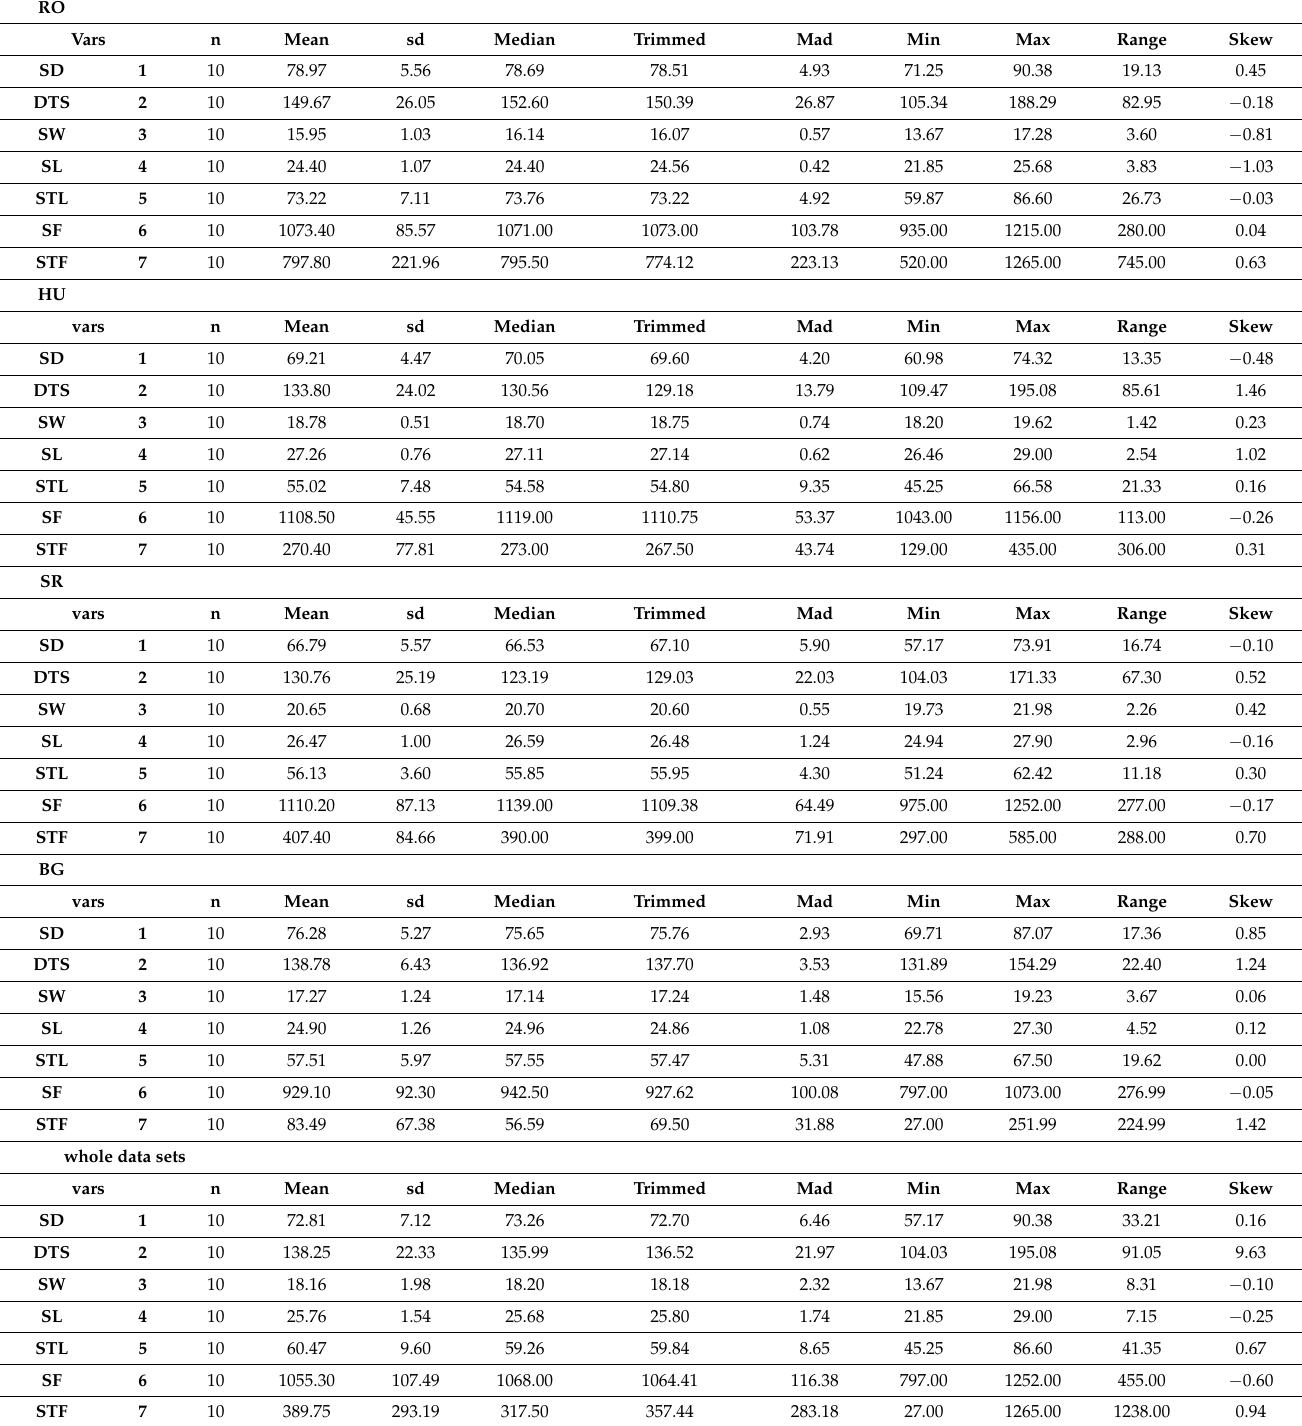
Table 2. Basic statistical parameters (mean, median, sd, range, skew) of MTs in all four populations (RO, HU, SR and